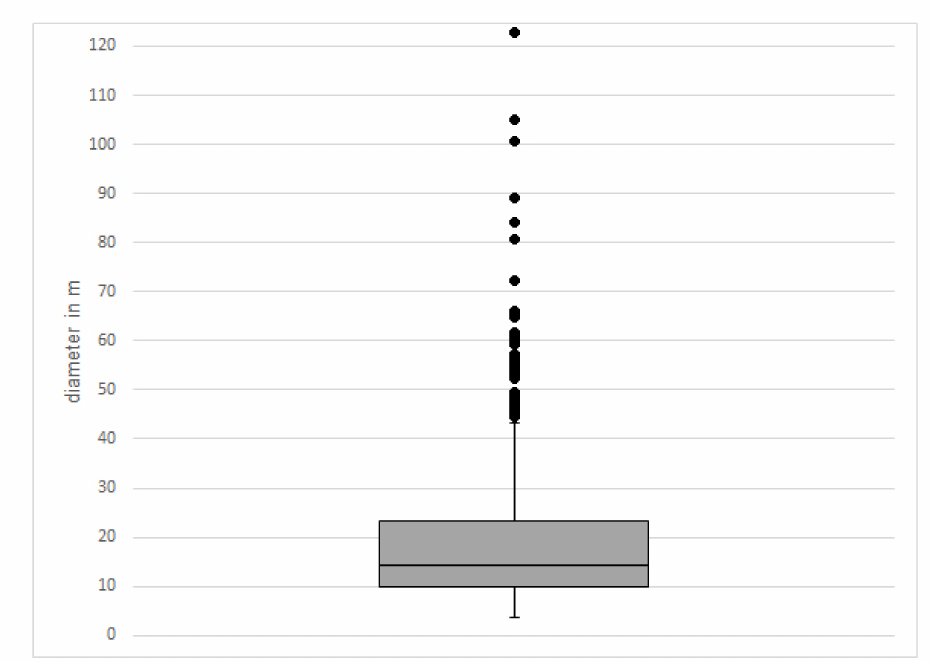
Figure 4. Box plot of mound diameter distribution excluding outliers (interquartile range × 1.5). Median: 14.2 m; Q1: 10.0 m; Q3: 23.4; Min: 3.8 m; Max (excluding outliers): 43.4